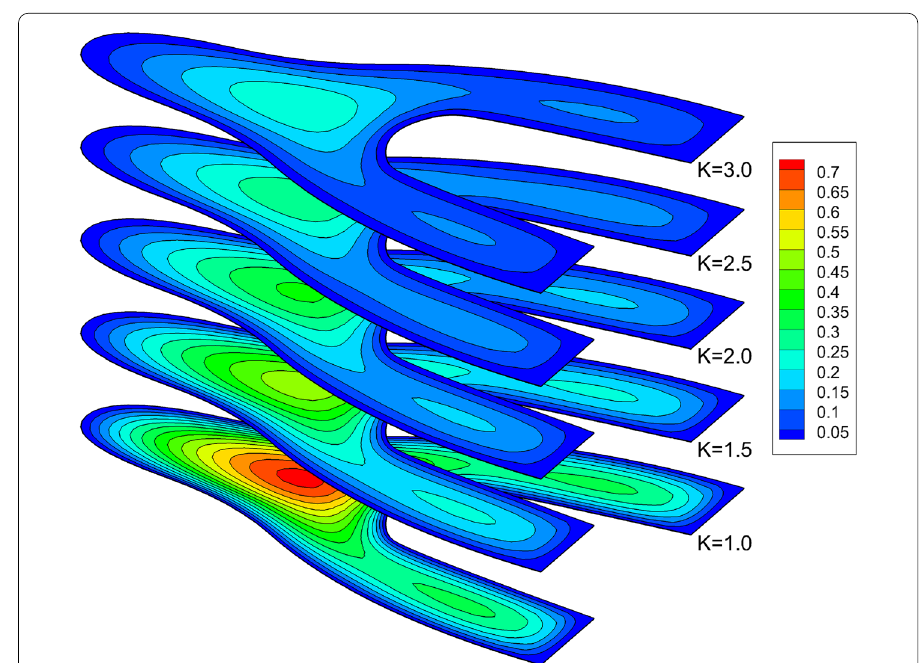
Fig. 16 Temperature distribution for different conductivities in the physical domain